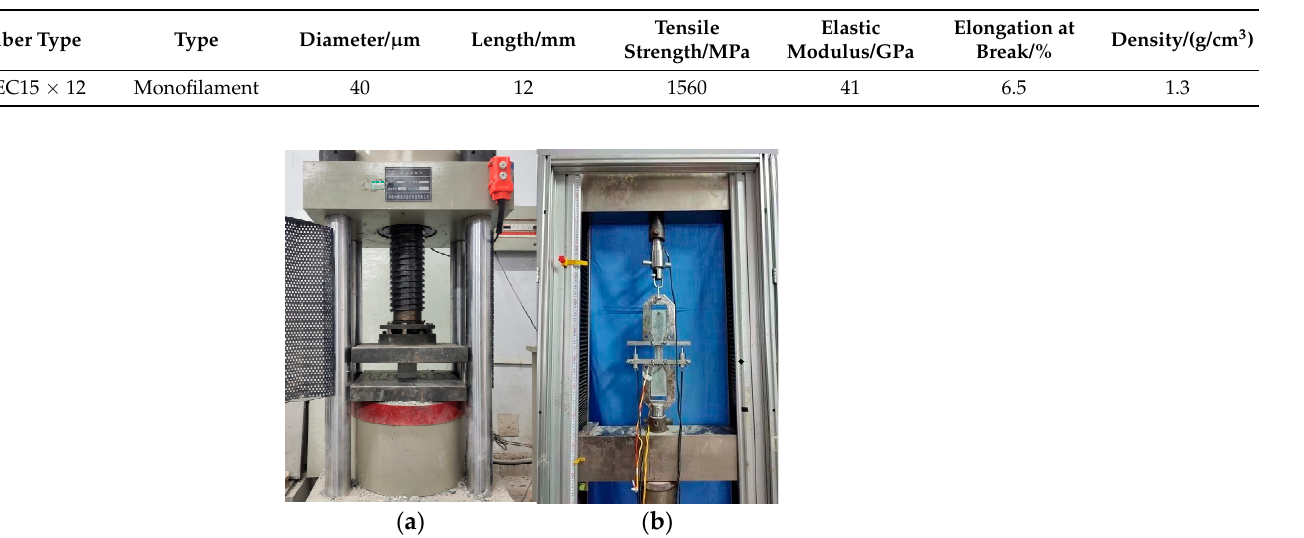
Figure 5. Stress-strain curve of ECC under tension. Table 2. ECC mix ratio in mass. Cement Sand Fly Ash